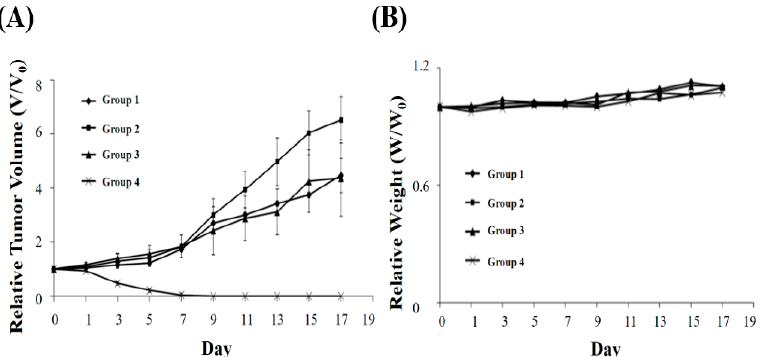
Figure 7. ( A ) In vivo tumour growth curves and ( B ) body weight curves in different groups of mice after various treatments indicated. The tumour volumes and body weight were normalised to their initial sizes and weight. Group 1: PBS; Group 2: PBS + NIR laser; Group 3: FeOxH–rGO; Group 4: FeOxH–rGO + NIR laser. Four groups of mice (n = 5 per group) were the same conditions with Figures 5 and 6.